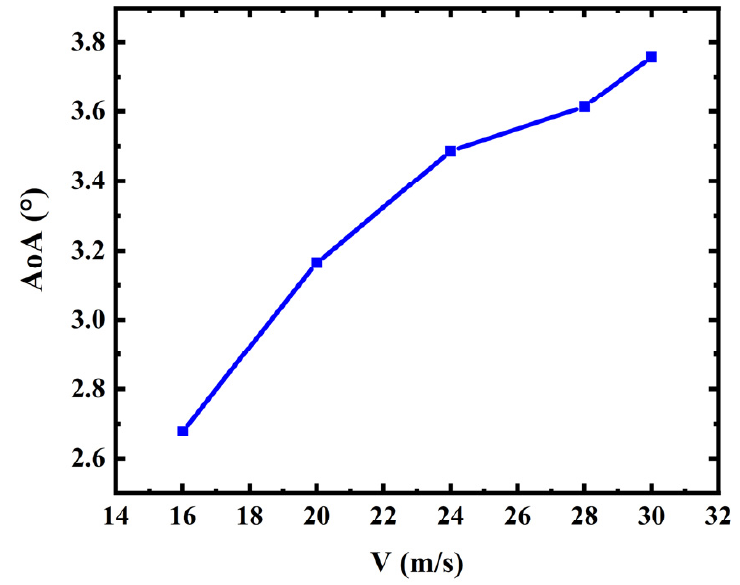
Figure 24. Trim angles of attack at different wind